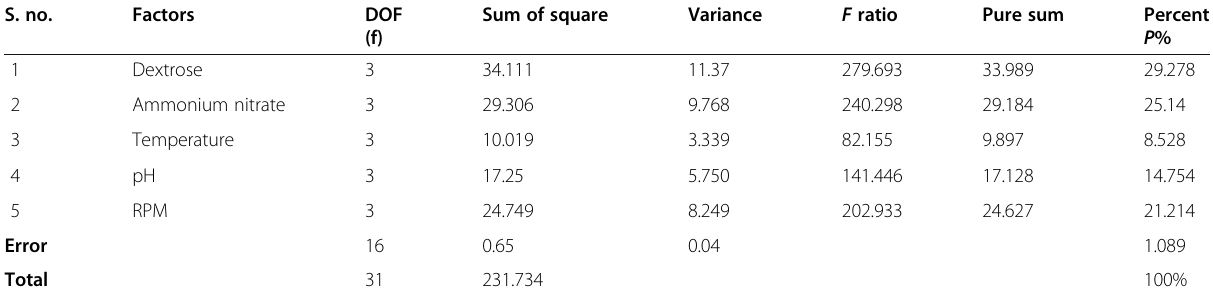
Table 5 Analysis of variance of the factors in step 1 using average of results S. no.